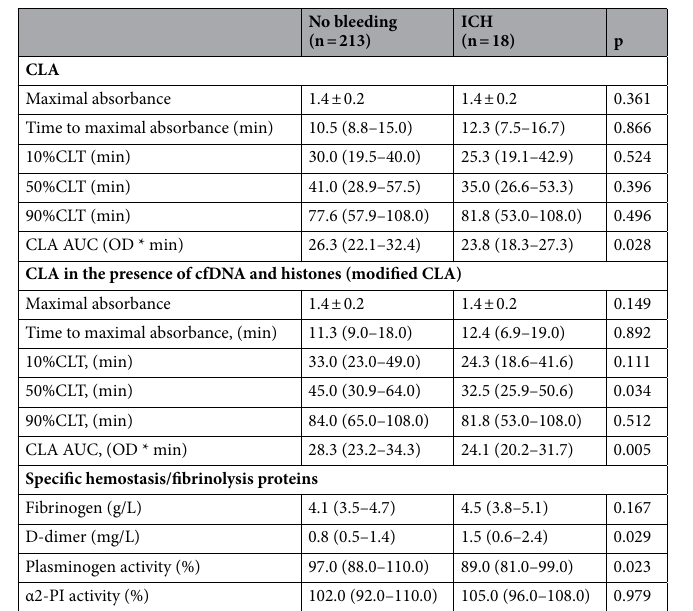
Table 3. Admission clot lysis assay (CLA) parameters and specific hemostasis/fibrinolysis protein levels according to the absence or presence of post-thrombolysis intracranial bleeding complications. Data are means ± SD or medians (interquartile ranges). α2-PI, α2-plasmin inhibitor; cfDNA, cell-free DNA; CLA, clot lysis assay; 10%CLT, 10% clot lysis time; 50%CLT, 50% clot lysis time; 90%CLT, 90% clot lysis time; CLA AUC, clot lysis assay area under the curve; ICH, intracerebral hemorrhage; n, number of